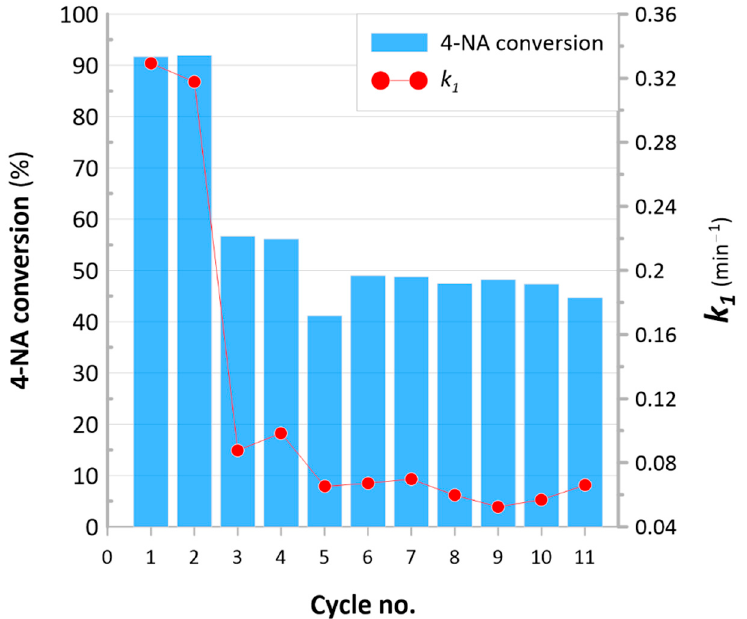
Figure 7. First-order rate constants ( k 1 ) and maximum conversion values of 4-NA to 1,4- phenylene- diamine within 8 min and using 50 mg of the Re@NCat.